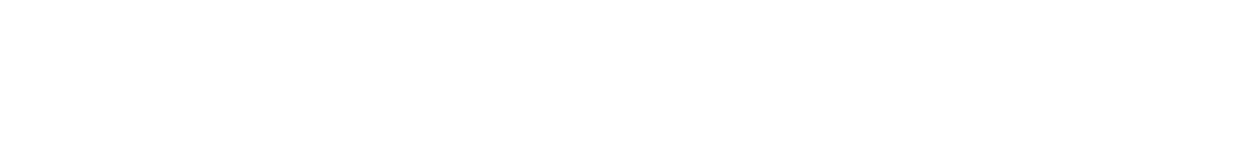
Frontiers in Built Environment |